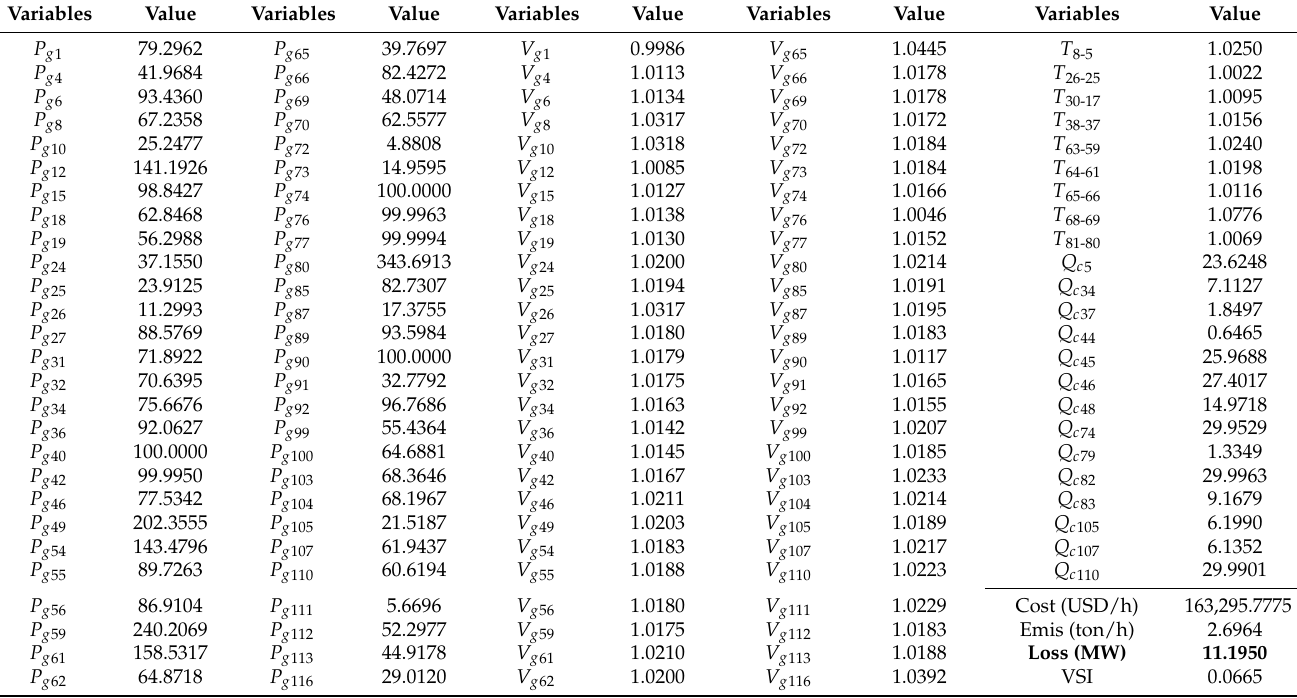
Table A4. Optimal solutions provided by MaMPA when considering transmission loss as the objective function in the IEEE 118-bus system (case